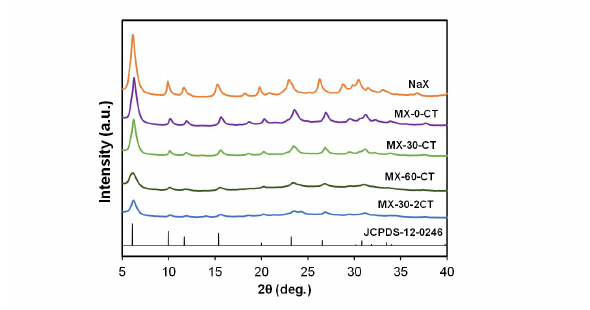
Fig. 1. XRD patterns of zeolite X and mesoporous zeolite